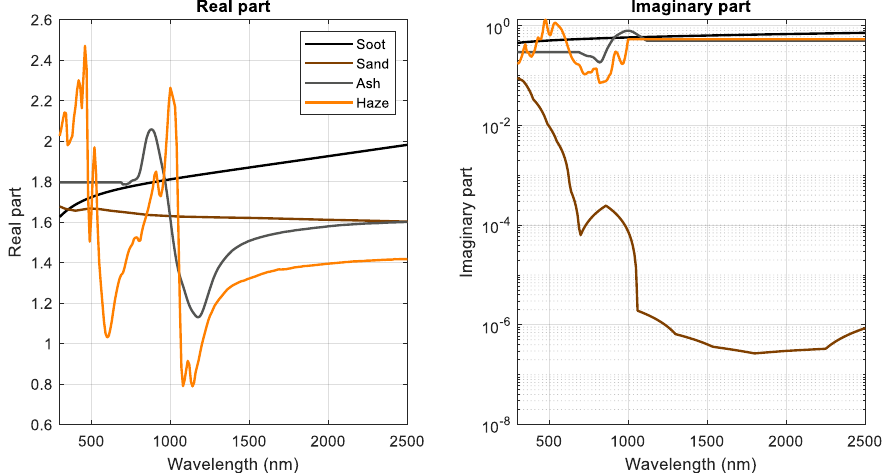
Figure 8. Real part and imaginary part of soot, sand, ash, and haze refractive index, obtained with as follows. Soot: correlation proposed by Chang and Charalampompoulos [44]; haze: effective medium model; ash: data from Deguine 2020 [45], and sand: data from Longtin et al. [46]. Table 3. Source for the mineral’s dielectric constants.